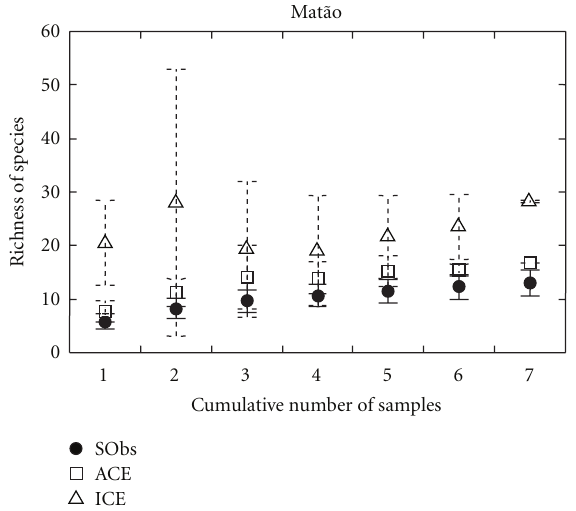
Figure 4: Richness of species observed and estimated using ACE (Abundance-based Coverage Estimator) and ICE (Incidence-based Coverage Estimator) indexes to the area of Mat˜ao.